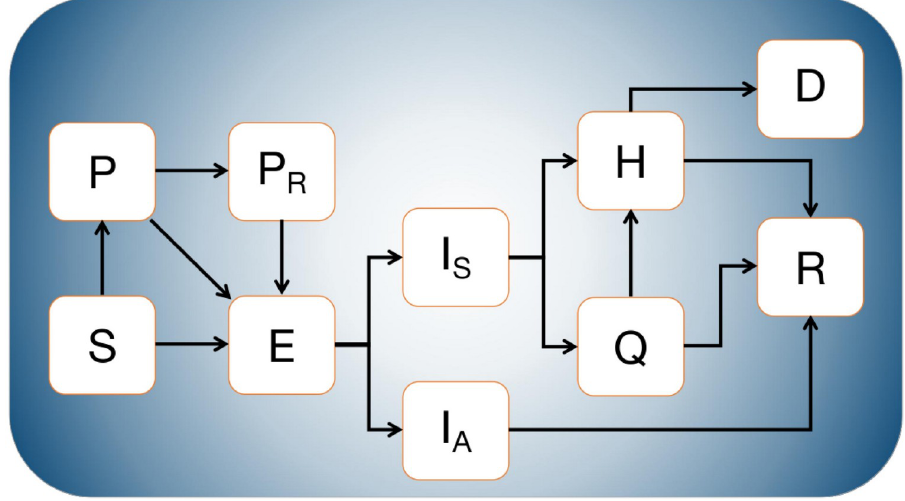
Fig 1. Flow diagram of the mathematical model. S , E , I exposed, asymptomatically infected, symptomatically infected, hospitalized, quarantined, recovered and dead individuals, respectively. Protected individuals ( P ) get involved in the disease dynamics when mitigation measures are implemented, whereas released population ( P R ) does so when relaxation of these measures occurs.